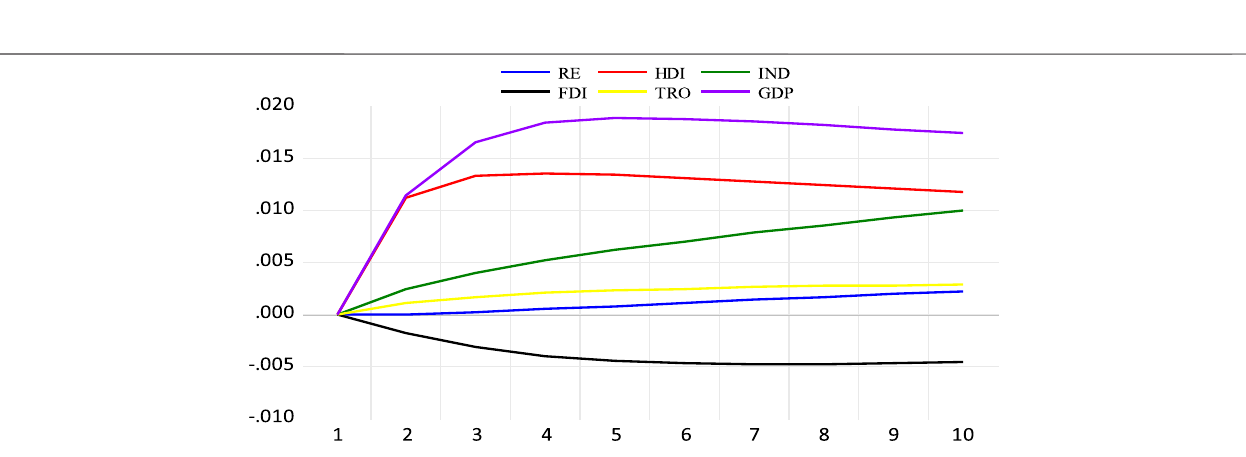
FIGURE 2 | Panel VAR impulse response functions for upper middle-income countries: Reaction of CO 2 emissions (CE) to renewable energy consumption (RE), humandevelopmentindex(HDI),industrialization(IND),foreigndirectinvestment(FDI),tradeopenness(TRO)andeconomicgrowth(GDP)onestandarddeviationshock.